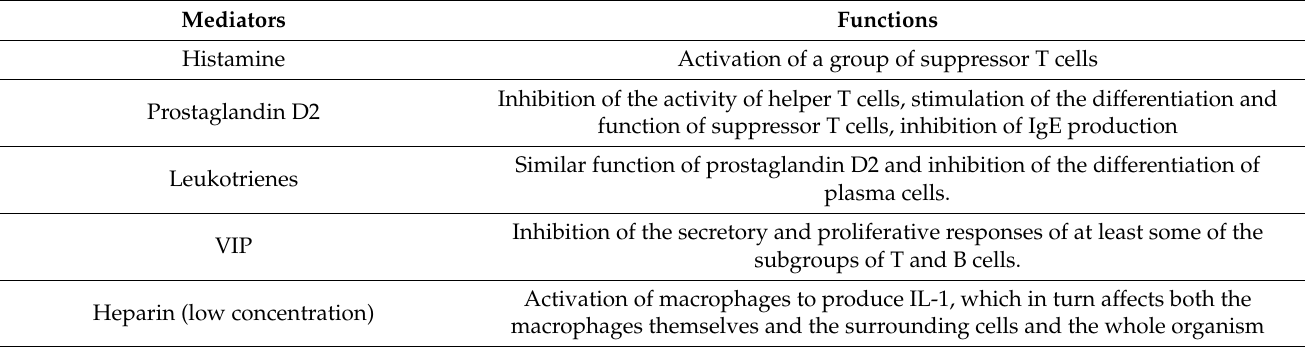
Table 3. Involvement of some mediators secreted by mast cells in the response of the immune